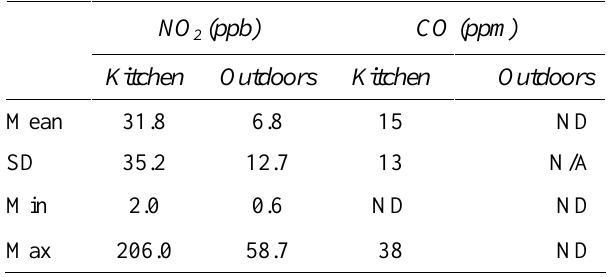
Table 5: NO and CO levels in different micro- 2